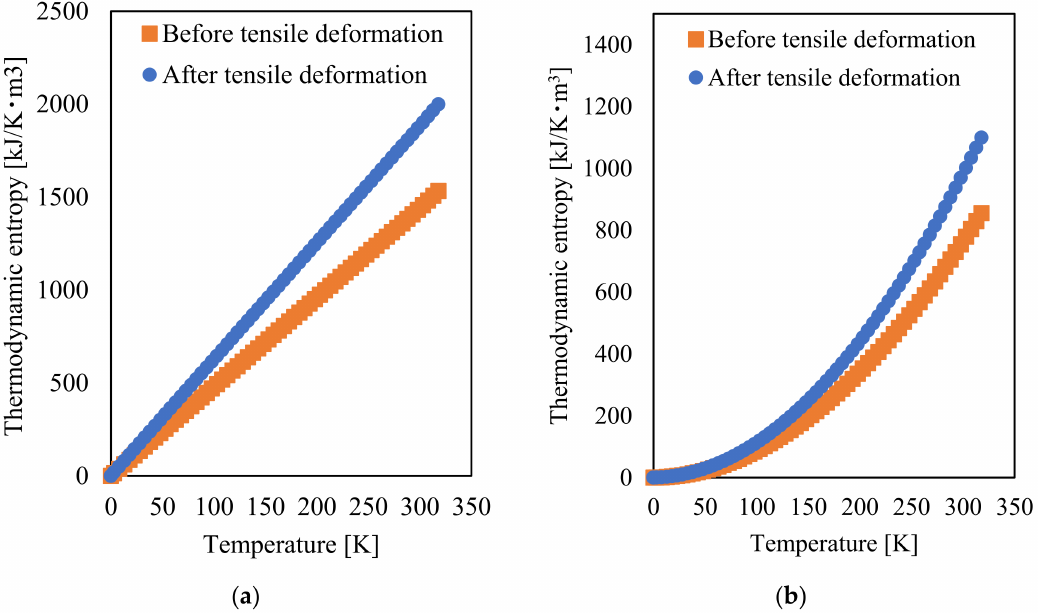
Figure 7. Thermalentropy generation before and after deformation, calculated using ( a ) linear and ( b ) quadratic extrapolation of the specific heat